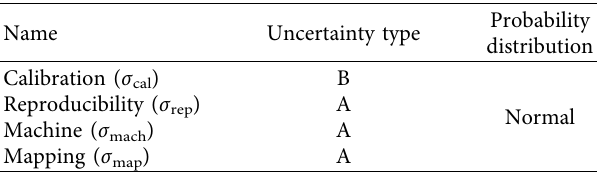
Table 2: Uncertainty budget for the irradiation of the microfila- ment